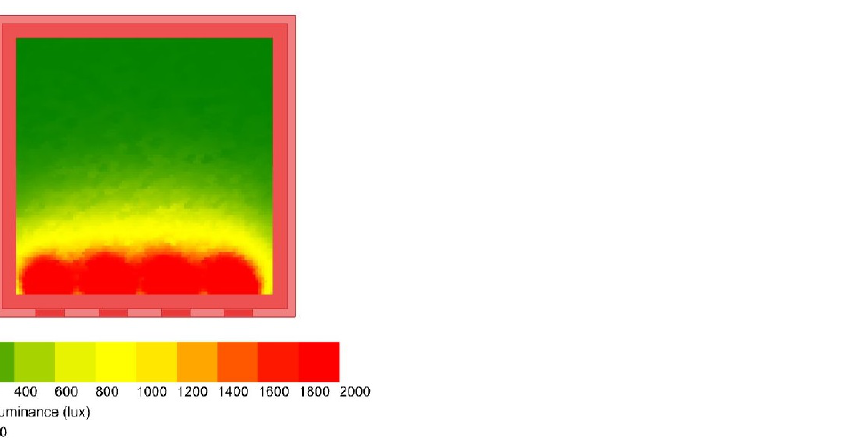
Figure 14. Daylight intensity in the considered office. The windows are positioned at the bottom of the figure [33].